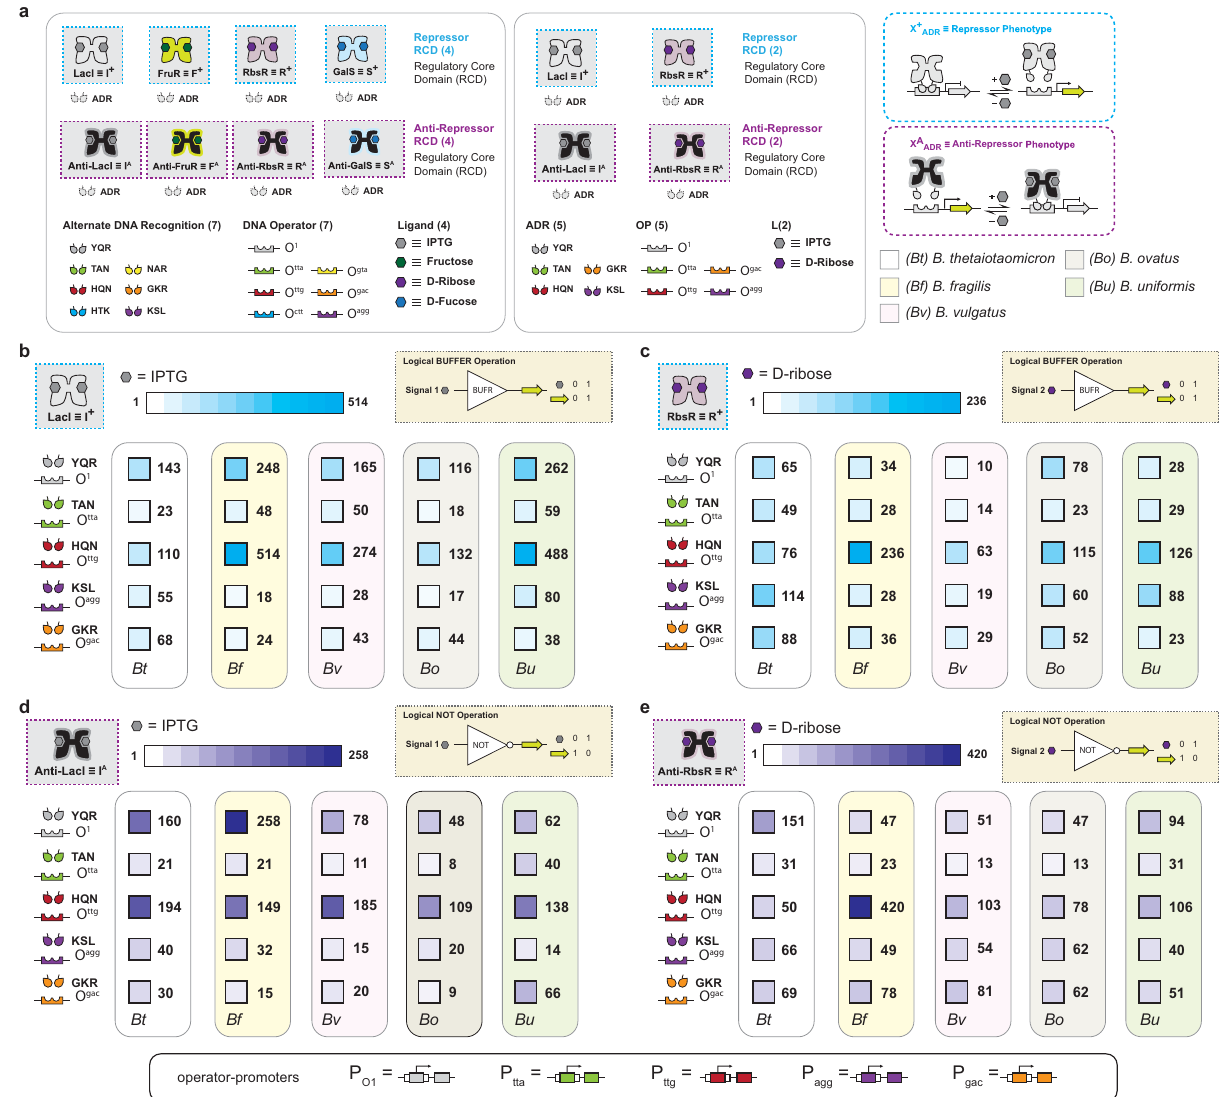
Fig. 1 Regulatory performance of transcription factors in Bacteroides species. a The initial set of transcription factors (TFs) tested in B. thetaiotaomicron (left box). The four signal-distinct regulatory core domains (RCDs) are shown with their repressor and anti-repressor cartoons. The cognate ligand for each RCD is shown as a colored hexagon. Each RCD can be paired with one of seven DNA-binding domains (DBDs) that each recognize and bind to a unique cognate DNA operator. Each DBD is abbreviated with a three-letter code where the three letters correspond to the residues located at positions 17, 18, and 22 of the LacI DBD. Cognate DBD-operator interactions are shown as the same color. The reduced set of functional TFs in B. thetaiotaomicron is shown in the middle box. The repressor and anti-repressor phenotypes are illustrated in the right boxes. b Dynamic range of LacI (I + ) TFs with alternate DNA recognition (ADR) when paired with cognate operators. Regulated promoters are illustrated at the bottom of the fi gure. Each box corresponds to the inducible promoter shown in the left columns when deployed in the Bacteroides species labeled below ( B. thetaiotaomicron ( Bt ), B. fragilis ( Bf ), B. vulgatus ( Bv ), B. ovatus ( Bo ), B. uniformis ( Bu )). The dynamic range of each promoter is presented next to its corresponding box which is shaded according to the legends at the top of each panel. Strains harboring inducible promoters were grown in the absence and presence of 10 mM inducer and assayed for luciferase activity (Methods). Dynamic range is presented as the high output state divided by the low output state. c Dynamic range of RbsR (R + ) transcription factors when paired with cognate operators. d Dynamic range of anti-LacI (I A ) transcription factors when paired with cognate operators. e Dynamic range of anti-RbsR (R A ) transcription factors when paired with cognate operators. See Supplementary Figs. 1, 2 for extended data. Source data are provided as a Source Data fi le. Data represent the average of n = 6 biological